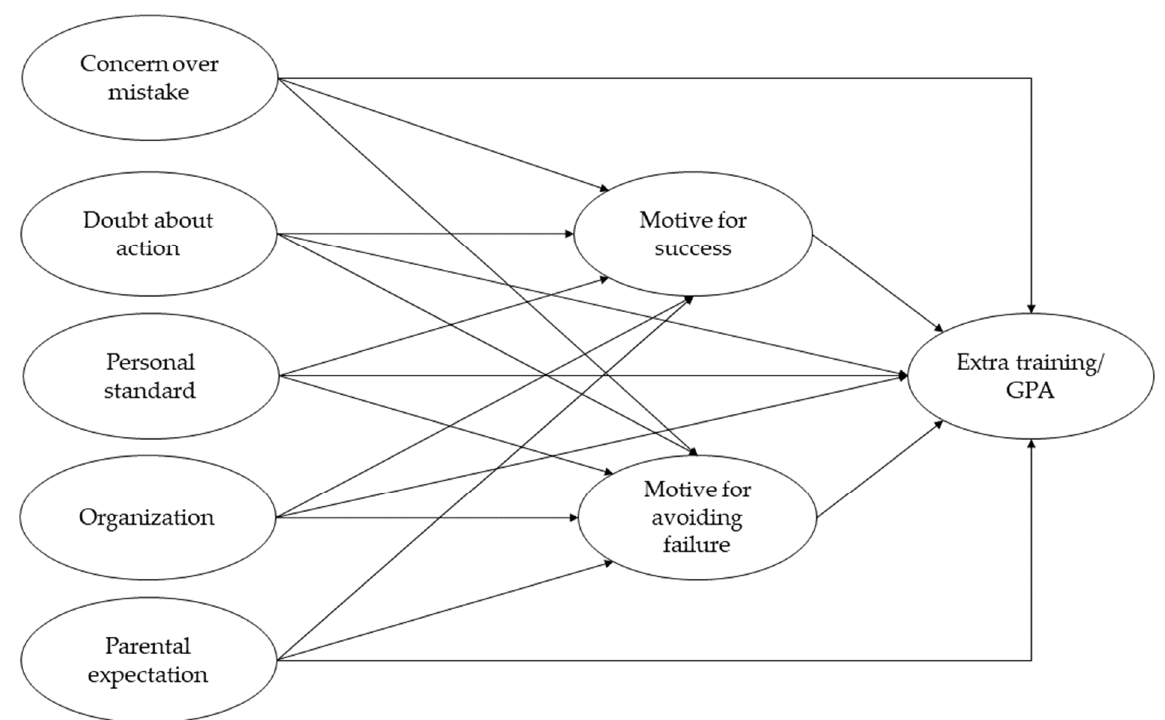
Figure 1. Hypothesized model of the mediating role of achievement motivation in the association of perfectionism with extra training and academic performance (GPA).